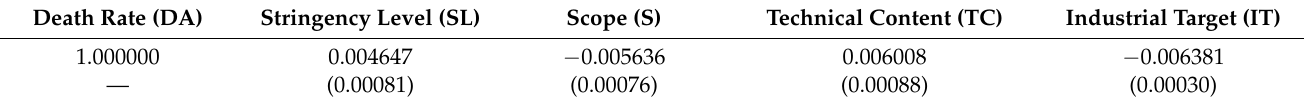
Table 7. Cointegration coefficient and